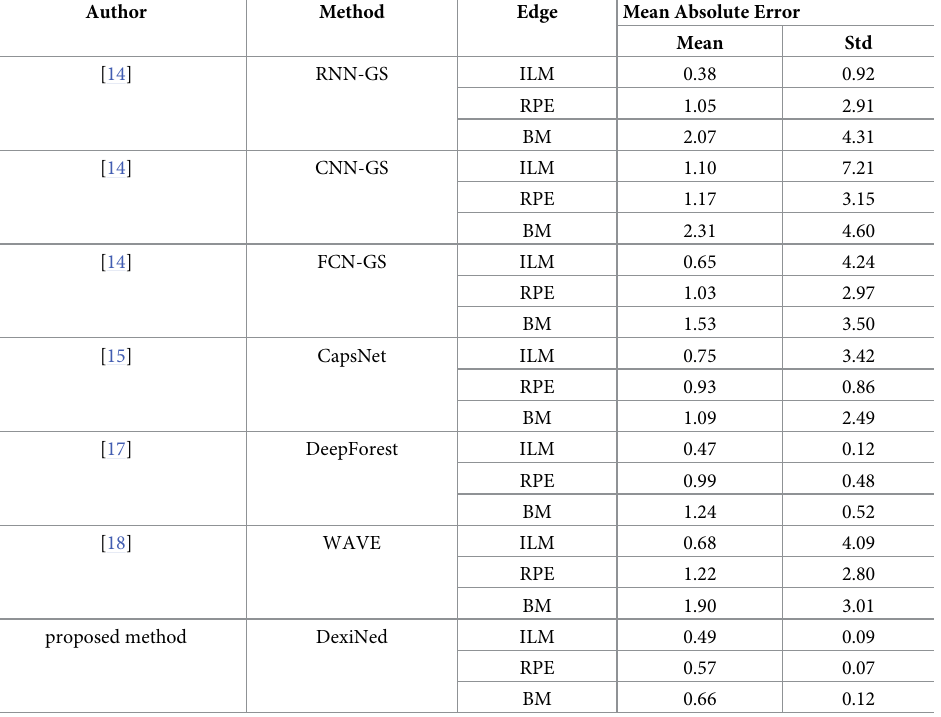
Table 2. Comparison with related